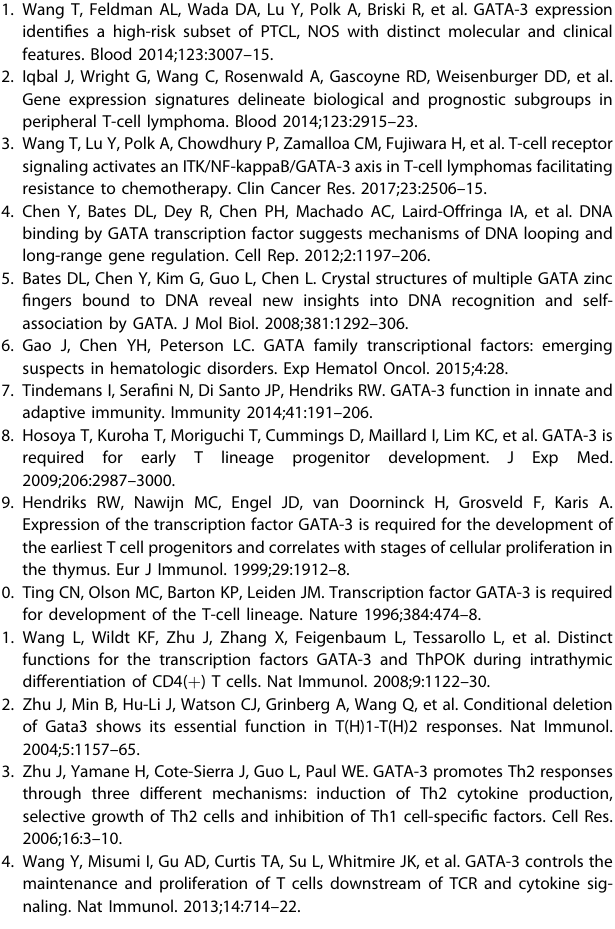
Fig. 6 GATA-3 acetylation is required for DNA binding. A Molecular dynamics simulations are performed comparing GATA-3 that is unacetylated at K358 (left) or acetylated at K358 (right). B Schematic of the in silico GATA-3 DNA-binding assay is shown. GFP antibody recognizes GATA-3-DNA probe complex, which is immunoprecipitated using DynaBeads. Primers speci fi c for the DNA probe are used to quantify the immunoprecipitated DNA probe in complex with GATA-3. GFP-tagged GATA-3 speci fi cally binds to DNA probes containing a palindromic consensus GATA binding motif (WT probe), but not a DNA probe in which the GATA binding motif has been mutated (Mut probe). C Quanti fi cation of GATA DNA probe (WT probe) binding to wild type- (WT), K358R/K377R mutated- (KR), and K358Q/K377Q- mutated (KQ) GATA-3 expressed in HEK293T cells. A representative immunoblot from 4 independent experiments is shown. D Schematic of the immobilization of Karpas299 using anti-CD45 antibodies on a glass coverglass for stable single-molecule imaging. Representative time-lapsed single-molecule images of GFP-tagged WT, gain-of-function (GOF, K358Q/K377Q), and loss-of-function (LOF, K358R/K377R) GATA-3 are shown. E Distribution of GATA-3 dwell times (>1 s) measured by single-molecule microscopy in the wild type (black), GOF (K-to-Q, shown in red), and LOF mutant (K-to-R, shown in blue) Karpas299 cells. The insert shows the distribution of individual GATA-3 dwell times (s) for each cell line. Dashed line separates GATA-3 binding events that are at least 4 s long from shorter events. Fraction of events longer than 4 s: 13% for the wild type, 17% for the K-to-Q mutant, and 10% for the K-to-R mutant. F Analysis of GATA-3 binding to representative target genes in Karpas299 cells overpressing GFP alone, GFP-tagged WT-, K358R-, K377R-, K358R/K377R-, and K358Q/K377Q GATA-3 by GATA-3 ChIP-qPCR. G Model of GATA-3 acetylation and transcriptional regulation of therapeutically relevant target genes. Data are mean ± s.e.m. (standard error of the mean). ns not signi fi cant. * p < 0.05, ** p <